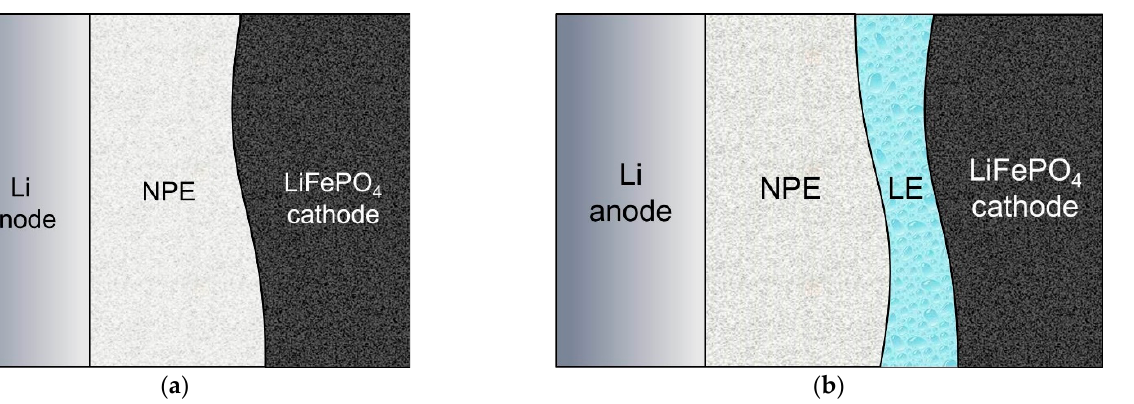
Figure 2. Assembly diagram of the Li/NPE/LiFePO 4 cells, where ( a ) LiFePO 4 surface was not treated in any way (“dry assembly”); ( b ) the surface of the LiFePO 4 cathode was treated with a LiTFSI solution in DOL-DME.